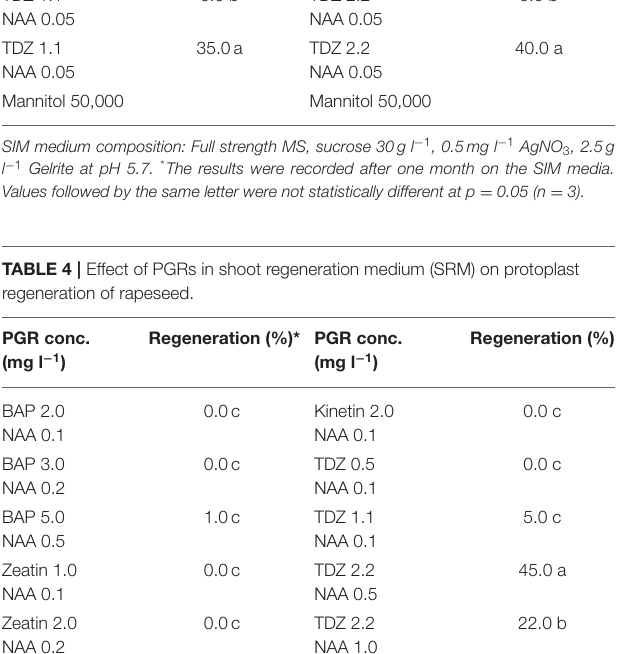
TABLE 3 | Effect of PGRs in shoot induction medium (SIM) on protoplast regeneration of rapeseed. PGR conc. (mg l − 1 )